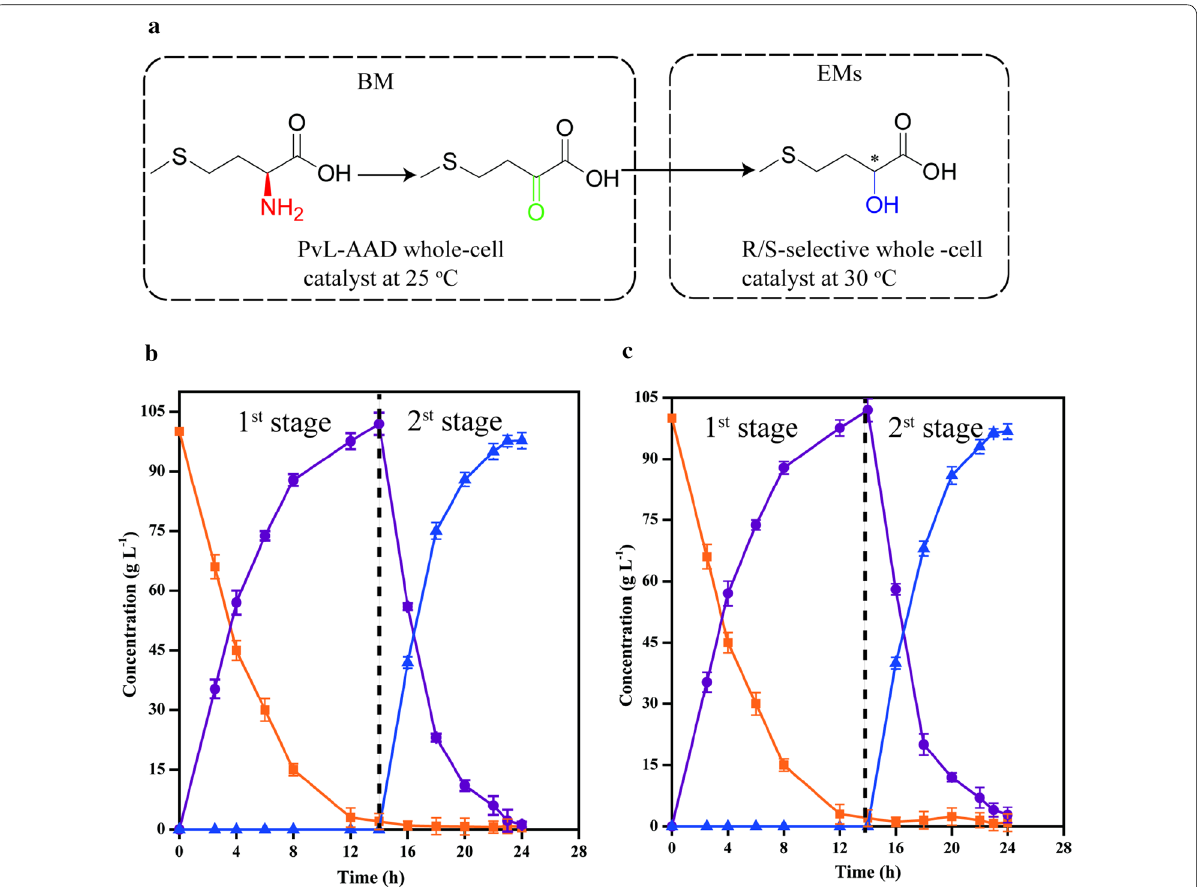
Fig. 5 One-pot production of ( R / S )-HMTBA from l -Met. a A “two stages in one-pot” strategy for the multi-enzyme cascade reaction to produce ( R )-HMTBA or ( S )-HMTBA using l -Met. b Time courses of the combination of BM and EM1 for producing ( R )-HMTBA from l -Met at a 1-L scale using the “two stage in one pot” strategy. c Time courses of the combination of BM and EM2 for producing ( S )-HMTBA from l -Met at a 1-L scale using the “two stage in one pot” strategy. For the first stage (0–14 h): a mixture (1 L) of 100 g L − 1 L-Met, 20 g L − 1 Pv l -AAD whole-cell catalyst, and 20 mM Tris–HCl buffer (pH 7.5) was incubated at 25 °C. For the second stage (14–23 h): adding 20 g L − 1 R/S-selective whole-cell catalyst, 140 g L − 1